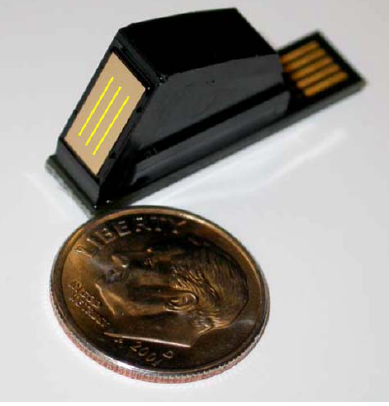
Figure 7. Spreeta 2000 sensor chip. Reprinted with kind permission of C. E. Furlong, Seattle.